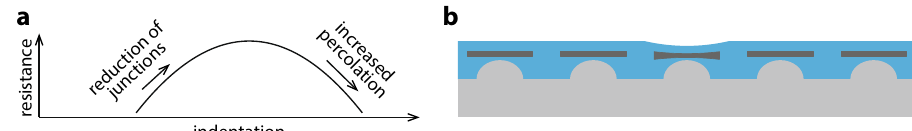
Figure 5. Qualitative model. ( a ) The interplay of two piezoresistive phenomena explains the sensitivity curve reversal. ( b ) Option for a practical e-Skin